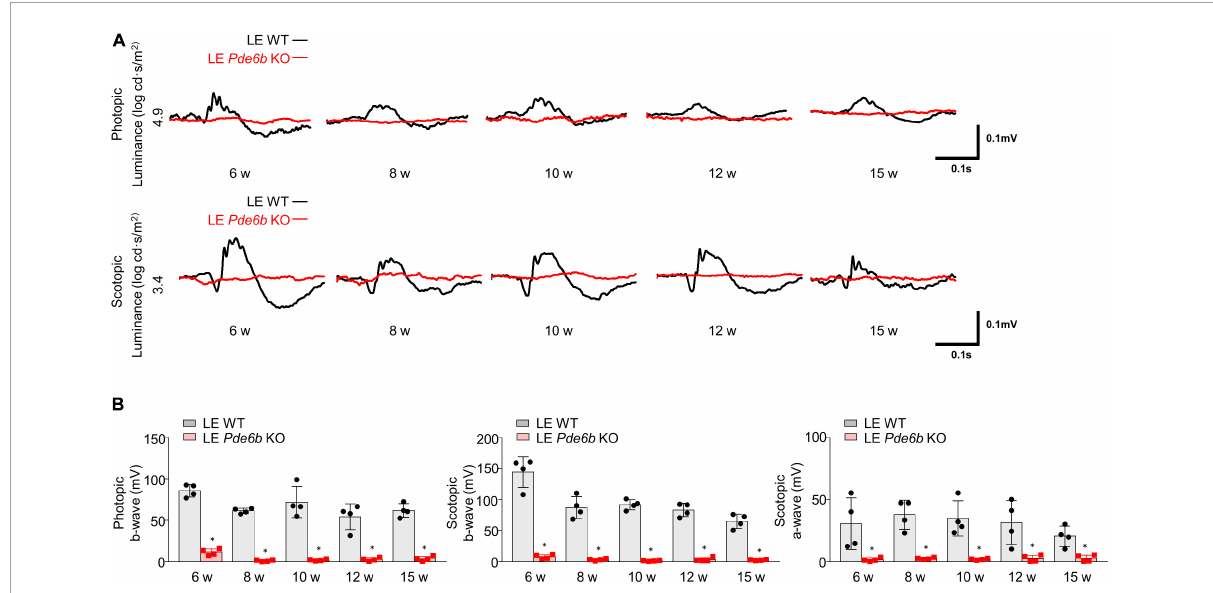
FIGURE5 Electroretinogram (ERG) of Pde6b -knockout Long–Evans rats. (A) Representative ERG data showing significantly decreased amplitude in both photopic and scotopic response in the LE Pde6b KO rat at each time point. (B) Quantification of the amplitude of photopic b-wave, scotopic a- & b-wave. LE, Long–Evans * P < 0.05, n = 4 eyes per